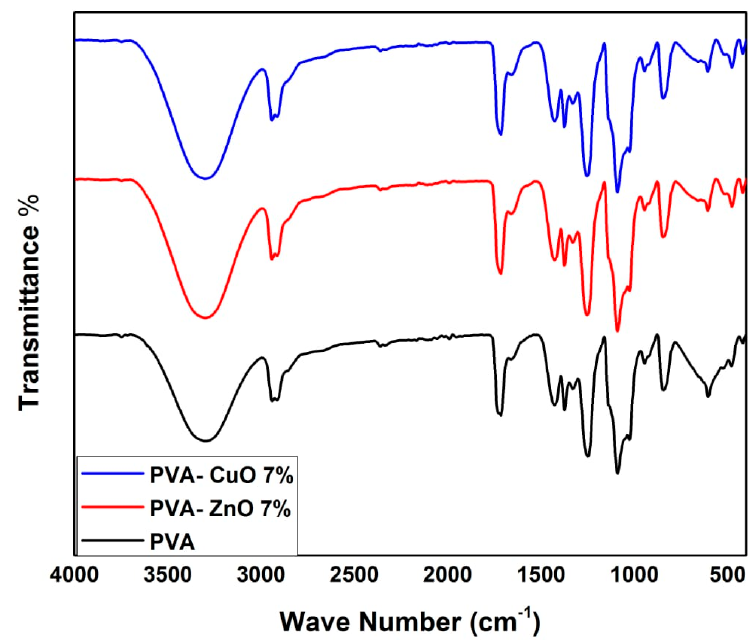
Figure 2. FT-IR of PVA, PVA-ZnO, and PVA-CuO nanofibers.